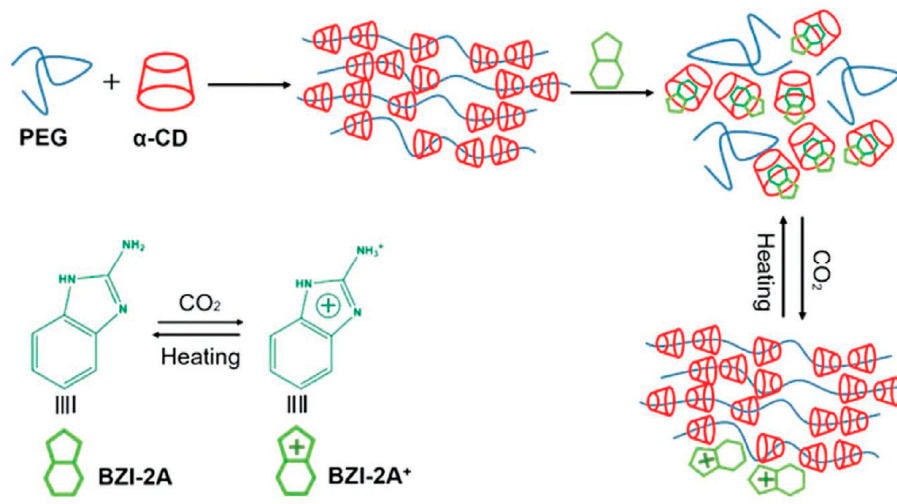
Figure 5. Preparation of the responsive polypseudorotaxane hydrogels triggered by CO 2 . Adapted with permission from Macromol. Chem. Phys. 2019 , 220 , 1900071 [112]. Copyright (2019) WILEY-VCH Verlag GmbH & Co. KGaA, Weinheim.